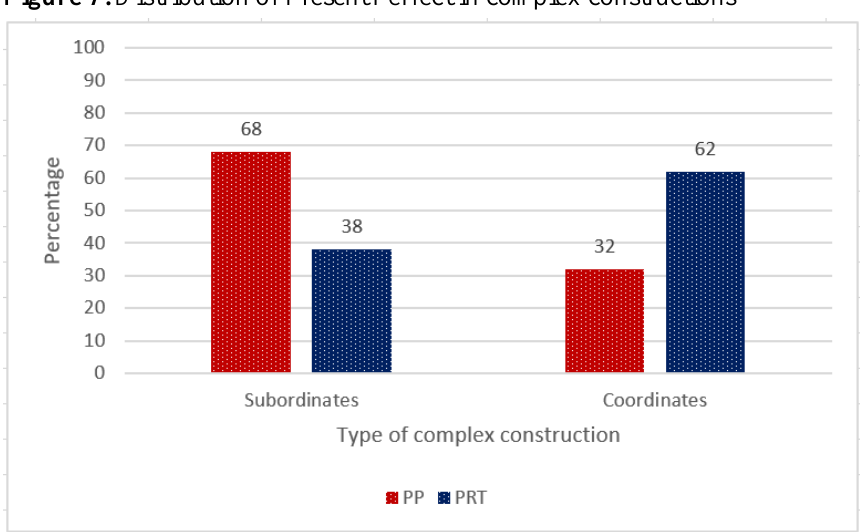
Source : Data extracted from